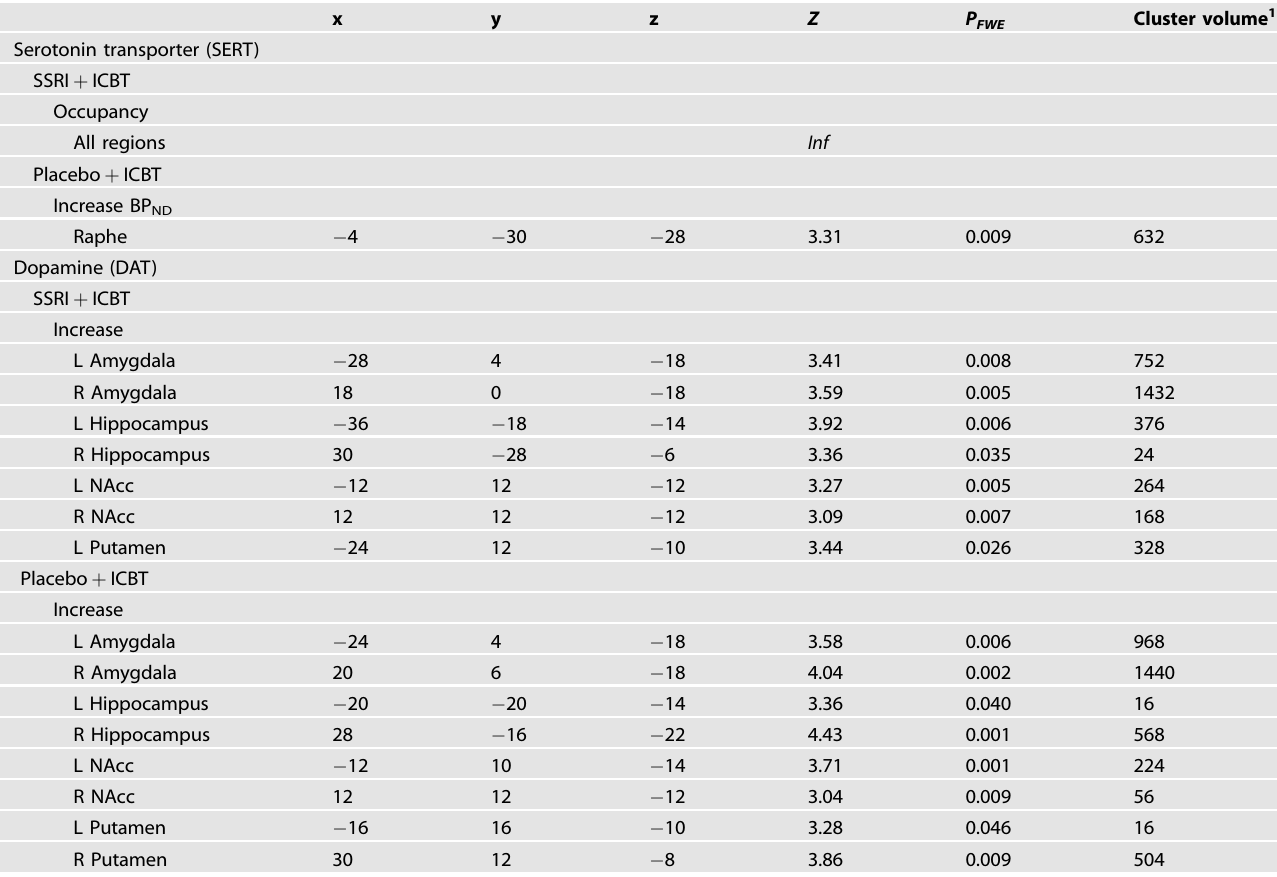
Table 2. Serotonin (SERT) and dopamine (DAT) transporter binding potential (BP ND ) changes in patients with social anxiety disorder (SAD) after treatment with SSRI + ICBT or placebo +